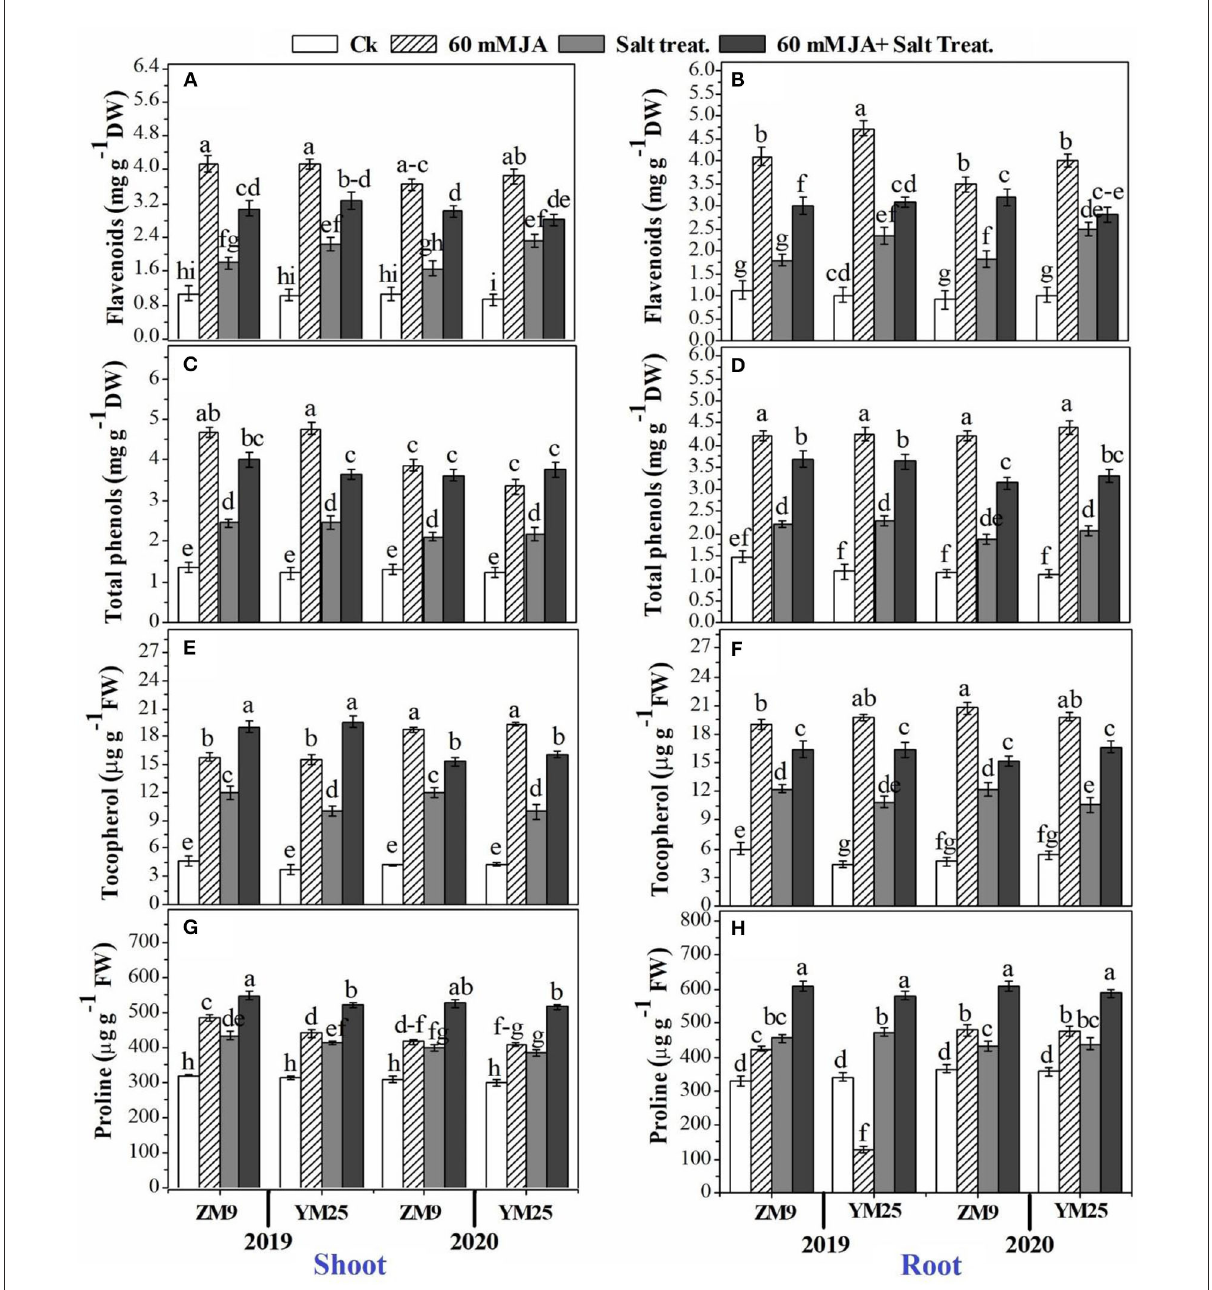
FIGURE3 Effects of JA priming on flavonoids in the shoot (A) and root (B) ; total phenols in the shoot (C) and root (D) ; tocopherol in the shoot (E) and root (F) ; proline in the shoot (G) and root (H) of two wheat cultivars Mai9 (ZM9, salt-sensitive) and Yang Mai25 (YM25, salt-tolerant) under control and salinity stress conditions during two consecutive growing seasons 2019 and 2020. Means sharing the same letters, for a parameter during a year, do not differ significantly at P ≤ 0.05 among the studied factors. Ck, control; S, salt treatment; JA, jasmonic